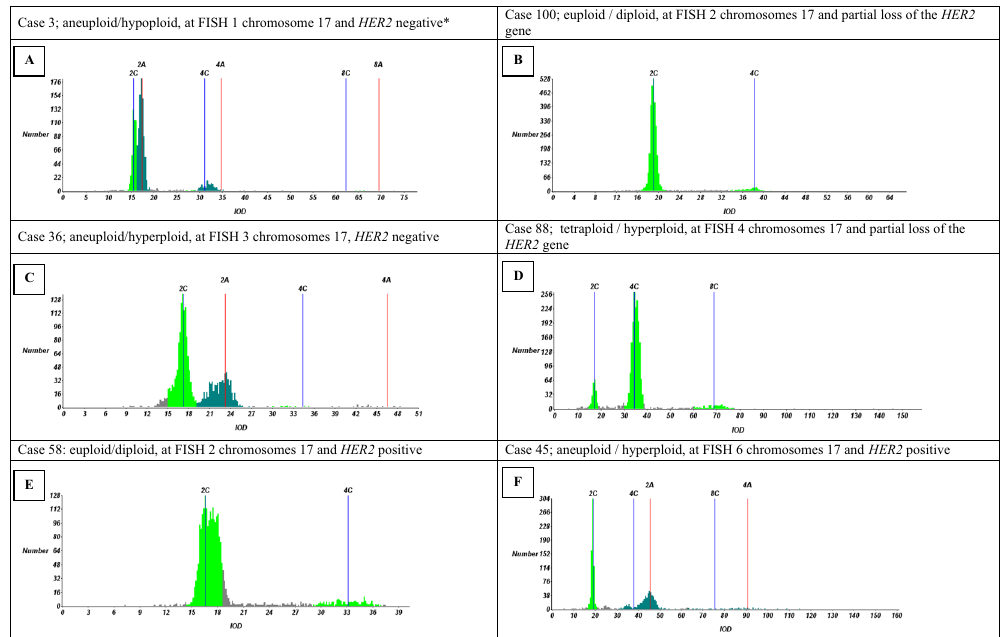
Figure 4. Breast cancer examples of DNA histograms. IOD: integrated optical density. * Probably hypoploidy although morphologically it was not possible to differentiate tumour nuclei from normal